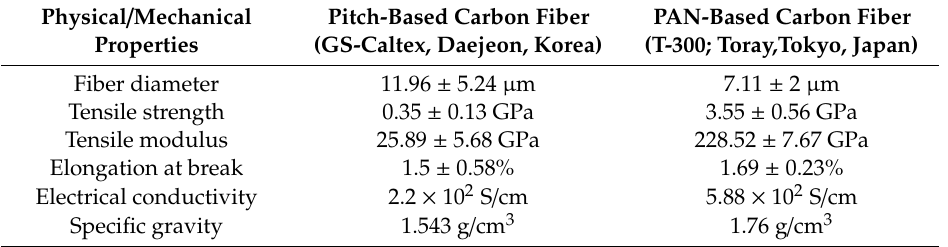
Table 1. Basic properties of the pitch- and PAN (polyacrylonitrile)-based carbon fibers [6].